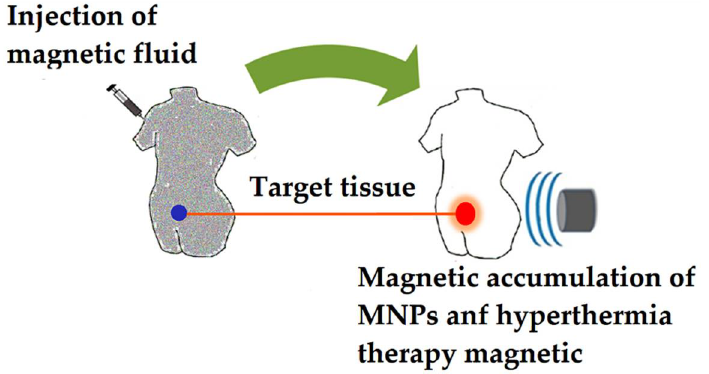
Figure 6. Scheme of therapeutic strategy using MNPs. Functionalized MNPs accumulate in the tumor tissue, then start with the hyperthermia treatment.